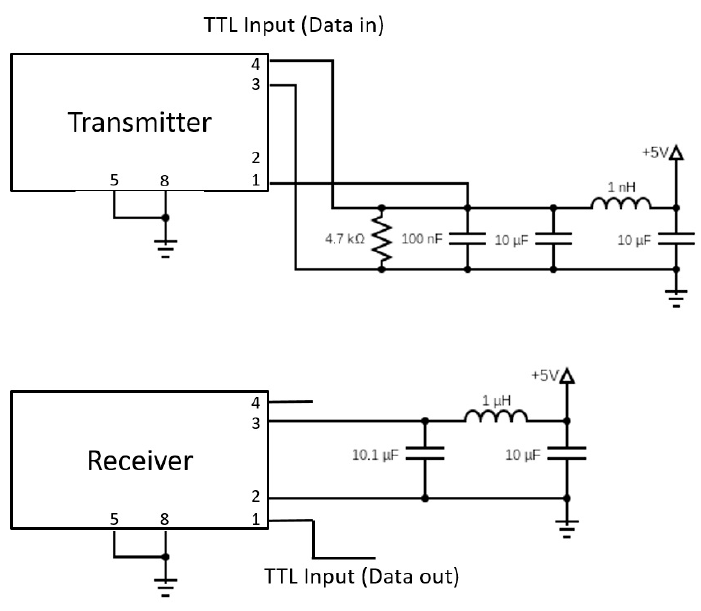
Figure 3. Recommended transmitter and receiver application circuit [17].